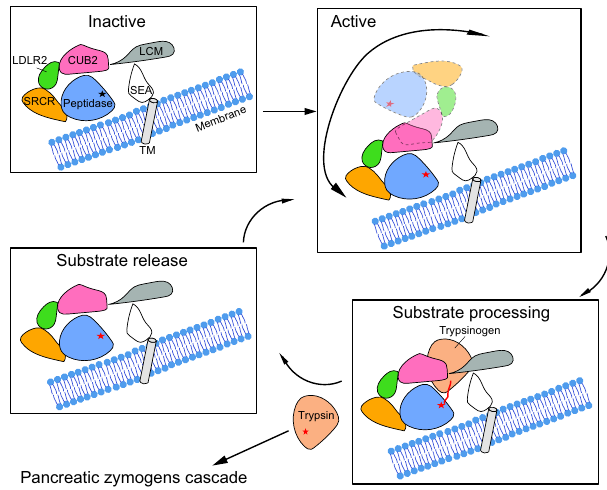
Fig.5|Proposedworkingmodelof h EP. Inthecatalyticprocess,thezymogen fi rst requirestrypsinorotherrelatedproteasesforactivation.Uponactivation,the h EP- core becomes dynamic to facilitate the exposure of the catalytic site and recruit- ment of substrates. The complex marked by the dashed line displays one of the active states stabilized by the inhibitor. Substrates such as trypsinogen bind to CUB2 with the substrate N-terminal tail placed into the catalytic site for cleavage. Following cleavage of the N-terminal tail, trypsin is released to initiate the pan- creatic zymogen cascade. h EP then returns to its dynamic state to recruit and catalyze the cleavage of more